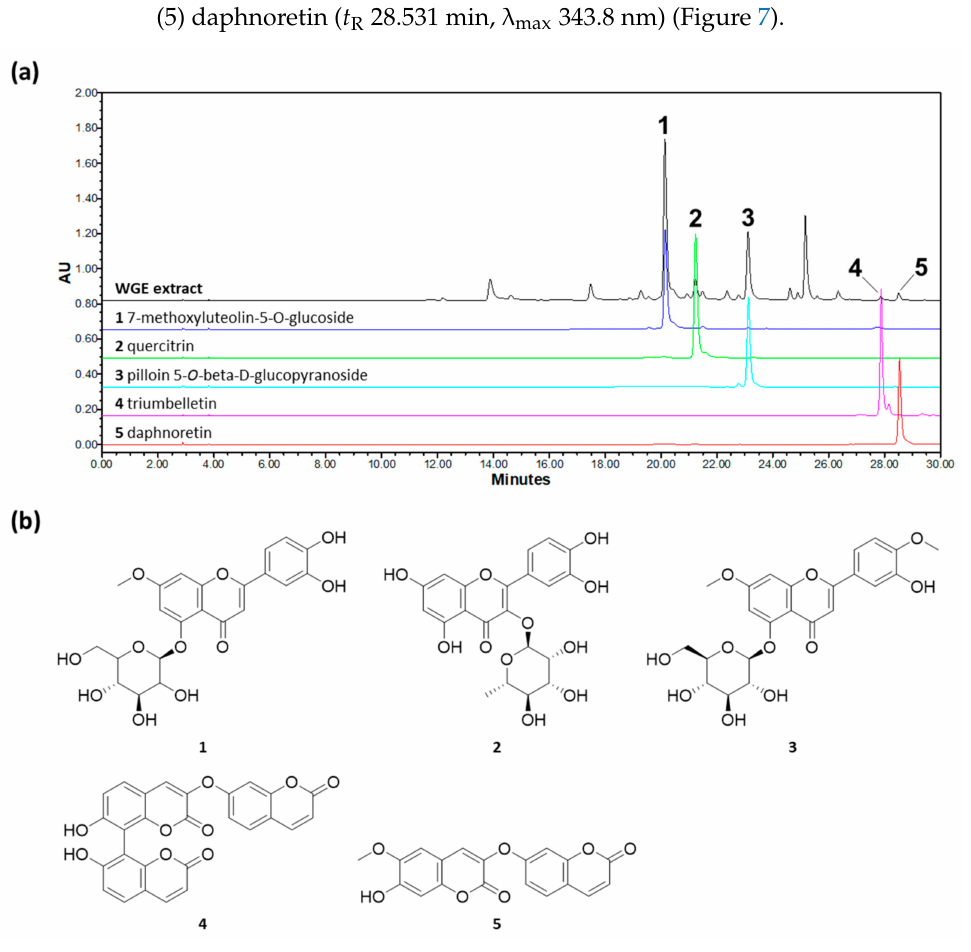
Figure 7. HPLC-PDA chromatograms of WGE at 340 nm ( a ) and chemical structure ( b ). Peaks: (1) 4-methoxyluteolin-5- O - glucoside; (2) quercitrin; (3) pilloin 5- O - β - D -glucopyranoside; (4) triumbelletin; (5)